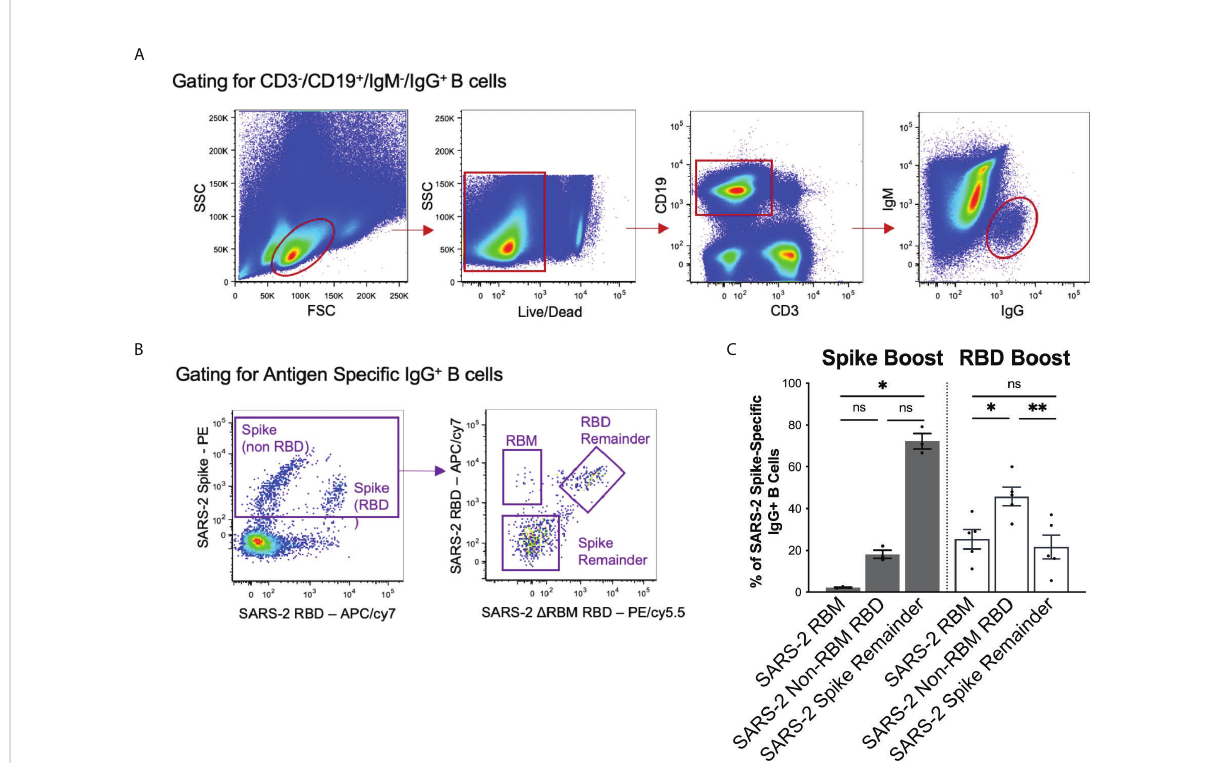
FIGURE 3 Flow cytometry gating scheme and results. (A) Gating strategy to select for CD3-/CD19+/IgM-/IgG + cells to isolate the memory B cell population. (B) Antigen speci fi c memory IgG responses were identi fi ed using a combination of SARS-2 spike, SARS-2 RBD, and SARS-2 RBM hg RBD fl ow hooks. SARS-2 spike-directed B cell responses were further separated by reactivity to into the RBM, RBD remainder (excluding RBM epitopes), and spike remainder (excluding RBM and RBD epitopes). (C) Spike-directed responses were binned into RBM, RBD remainder (excluding RBM epitopes), and spike remainder (excluding RBD and RBM epitopes) populations using relevant probes in fl ow cytometry. Data is shown as a percentage of total spike-speci fi c IgG + B-cells. Statistical signi fi cance was determined using Kruskal-Wallis test with posthoc analysis using Dunn ’ s test corrected for multiple comparisons (*p < 0.05, **p < 0.01); ns, not signi fi